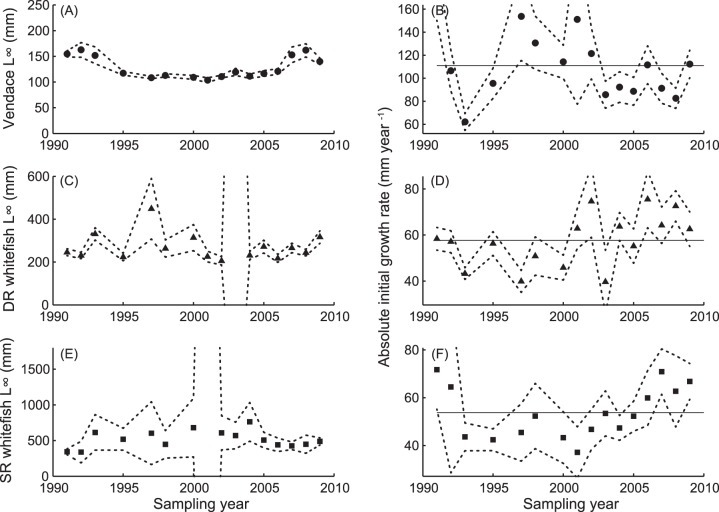
Parameters from the von Bertalanffy growth models, based on the age and length structure observed in yearly catches of vendace (A, B), densely-rakered (DR) whitefish (C, D), and sparsely-rakered (SR) whitefish (E, F).The changes in L∞ with time are shown in the left panels (A, C, E). In the right panels (B, D, F) the development in absolute initial growth rate is shown, with the mean indicated by the solid horizontal line. The dotted lines indicate parameter 95% confidence intervals.